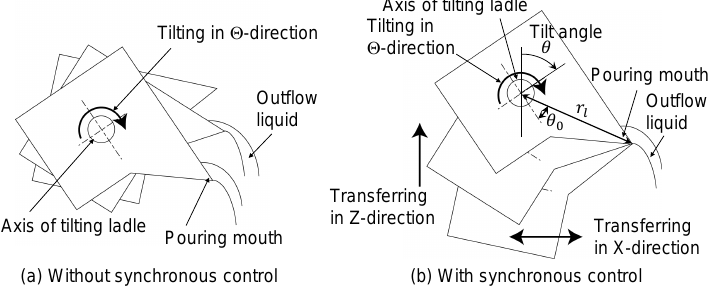
Figure 7. Illustrations of ladle motions in the X - and Z -directions, controlled synchronously to tilt the ladle in the Θ -direction: ( a ) Ladle motion without synchronous control, and ( b ) ladle motion with synchronous